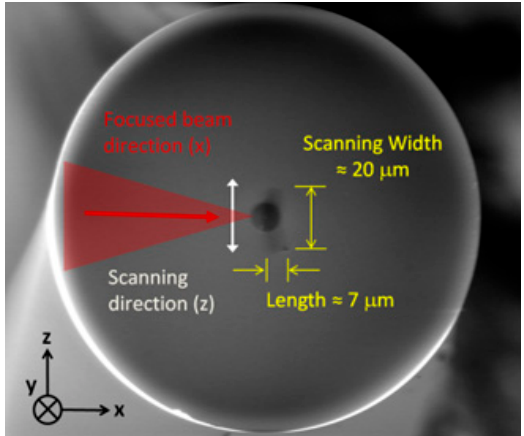
Figure 3. SEM image of the fiber cross section with transverse scanning over ± 10 µm for an exposure time of 60 s at 75 µJ of energy. The laser beam used was Gaussian, with d ~11 mm. The fiber is an unloaded SMF-28.